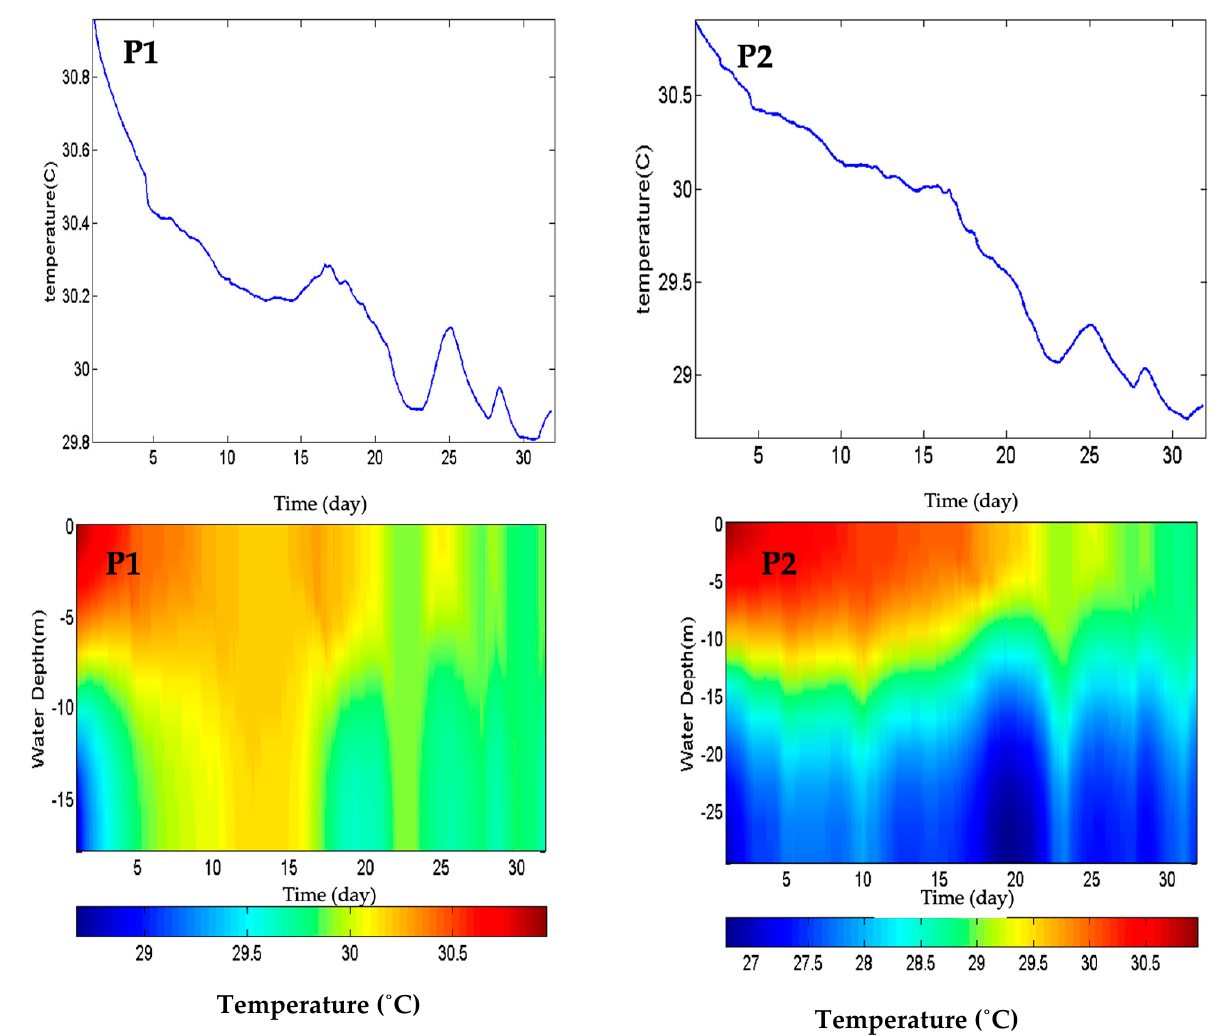
Figure 12. Variations of SST and water temperature across the water column during one-month simulation in October 2009 for: ( left panels) station P1 and ( right panel) station P2. Location of stations is based on Figure 1.